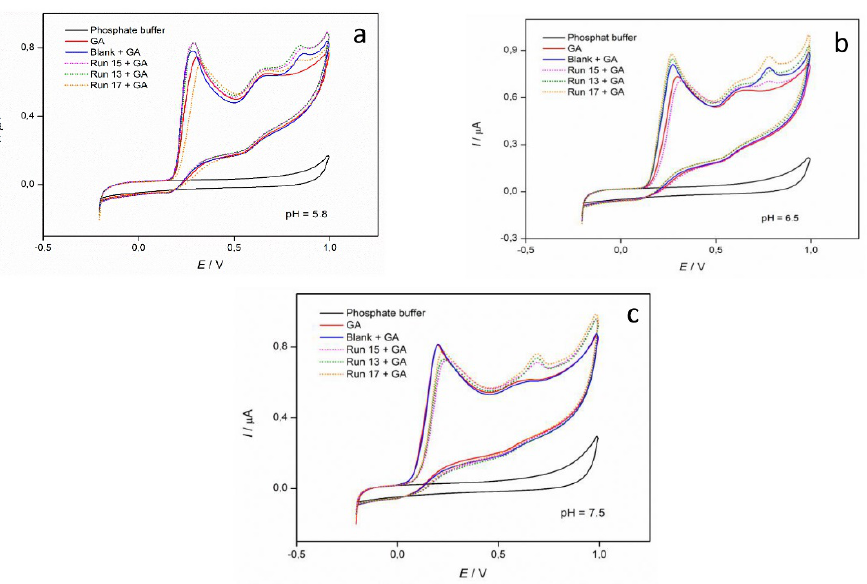
Figure 8. Cyclic voltammograms of GA (c = 1.5 mM) (—) and calcium oxalate precipitate (Blank (—), Run 15 (—), Run 13 (—), Run 17 (—)) with added GA ( c = 1.5 mM) in phosphate buffer solutions pH = 5.8 ( a ), 6.5 ( b ) and 7.5 ( c ). Scan rate 100 mV/s.